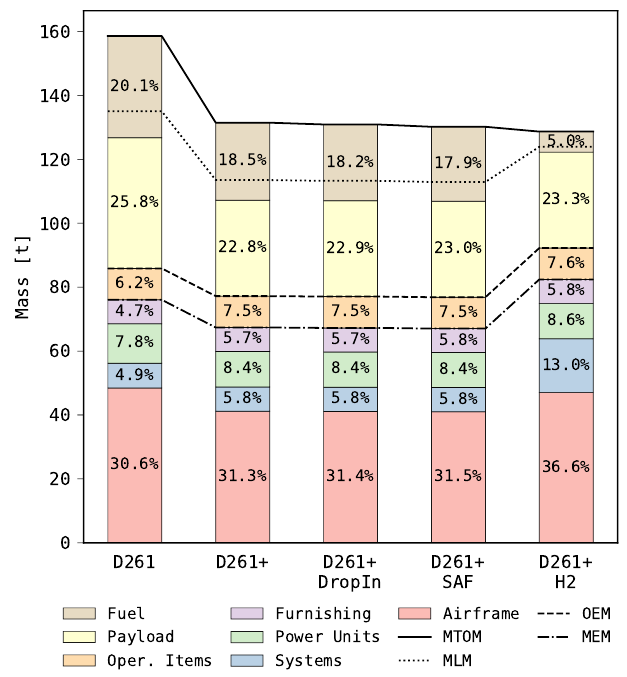
Figure 10. Masses of all concepts for the MTOM with max. payload